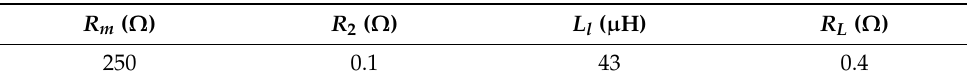
Figure 1. Equivalent circuit of the CT. Table 1. Parameters of the equivalent circuit.